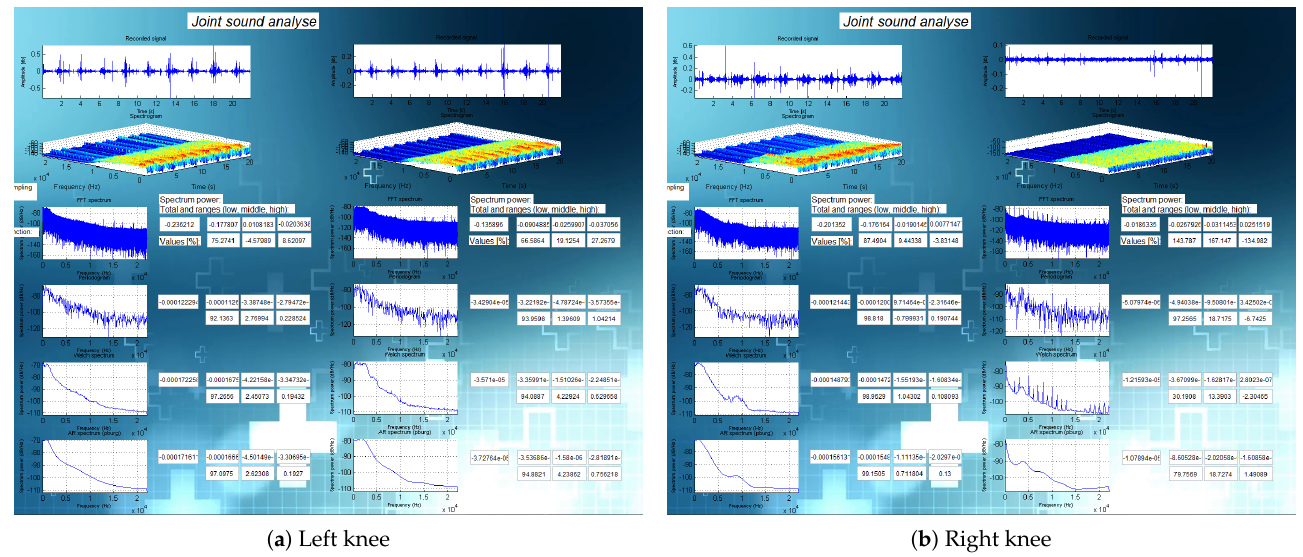
Figure A14. Analysis for subject